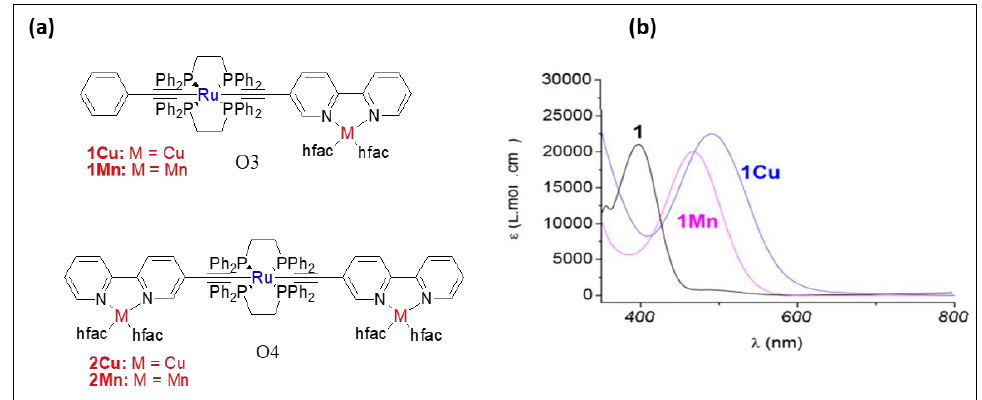
Figure 7. ( a ) Structures of bimetallic and trimetallic Ru/Cu and Ru/Mn complexes O3 and O4 and ( b ) the optical absorption spectra (in CH 2 Cl 2 ) of O3 when M = Cu (1Cu) and Mn (1Mn) along with the corresponding monometallic Ru-bipyridyl compound ( 1 ). Reprinted (adapted) with permission from Di Piazza, E.; Boilleau, C.; Vacher, A.; Merahi, K.; Norel, L.; Costuas, K.; Roisnel, T.; Choua, S.; Turek, P.; Rigaut, S., Ruthenium carbon-rich group as a redox-switchable metal coupling unit in linear trinuclear complexes. Inorg. Chem. 2017, 56, (23), 14540 – 14555. Copyright 2017 American Chemical Society.